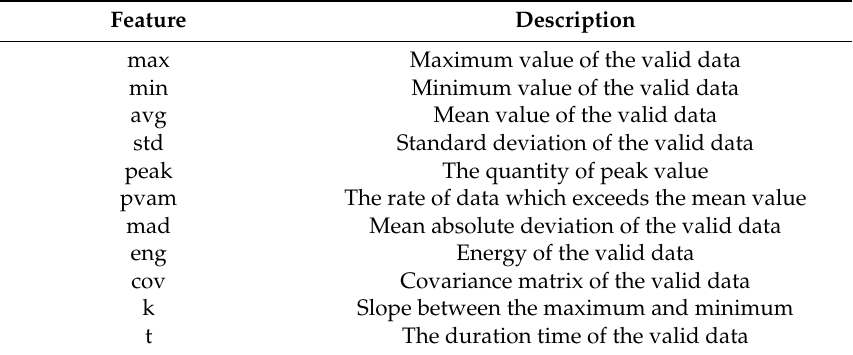
Table 4. The features extracted from the valid